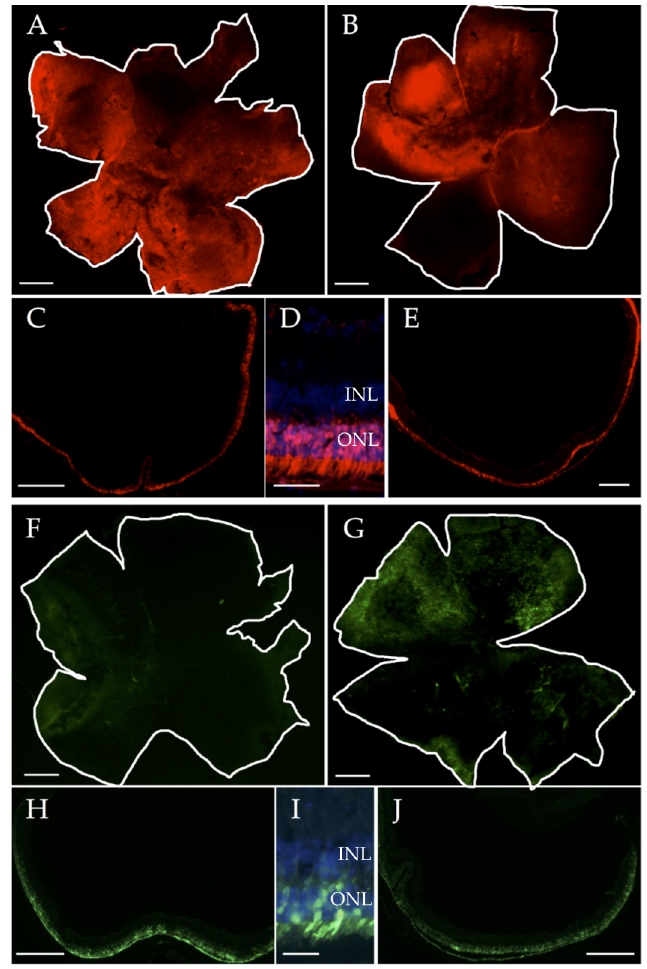
Figure 1. Representative images of mCherry ( A – E , red) and GFP ( F – J , green) reporter expression after sub-retinal injections of ssAAV-Anc80 solutions, as seen in the whole mount and retinal sections. ( A , C ) Retinas treated with ssAAV-Anc80-anti-miR-6937-5p. ( B , E ) Retinas treated with ssAAV-Anc80- scramble-inhibitor. ( F , H ) Retinas treated with ssAAV-Anc80-pre-miR-142a-5p. ( G , J ) Retinas treated with ssAAV-Anc80-scramble-precursor. ( D , I ) Expression of AAV-Anc80 is restricted to photoreceptor cells, as can be observed in high magnification of retinal sections with nuclei stained with DAPI (blue). Abbreviations: INL: inner nuclear layer; ONL: outer nuclear layer; AAV: adeno- associated virus. Scale bars: 400 μ m, except in ( D , J ): 50 μ m.